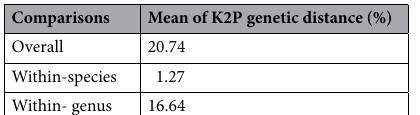
Table 1. K2P genetic distance depends on the species and genus of Leptonetidae.